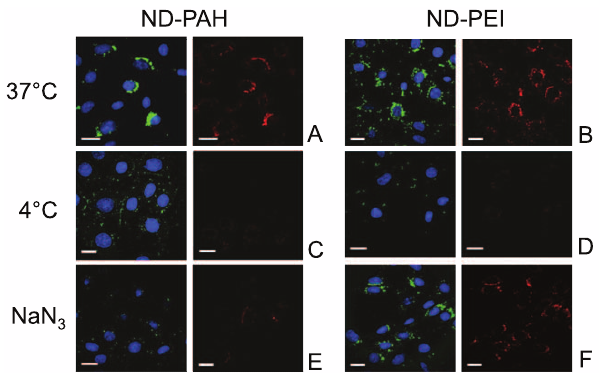
Figure 1. Study of the energy-dependent endocytosis of fluorescent nanodiamonds in NIH/3T3 EWS-Fli1 cells. The fNDs (red channel) loaded with FITC-labeled siRNA (green channel) were observed by confocal microscopy (Leica TSC SPE) after 4 h of incubation. We used 50 nM siRNA vectorized with ND-PAH or ND-PEI at mass ratios of 1:25 and 1:75, respectively. Cells were incubated at 37 u C (control) (A, B), 4 u C (C, D), or 37 u C after treatment for 30 min treatment with NaN 3 (E, F). Nuclei are labeled with DAPI (blue channel), scale bars: 20 m m.